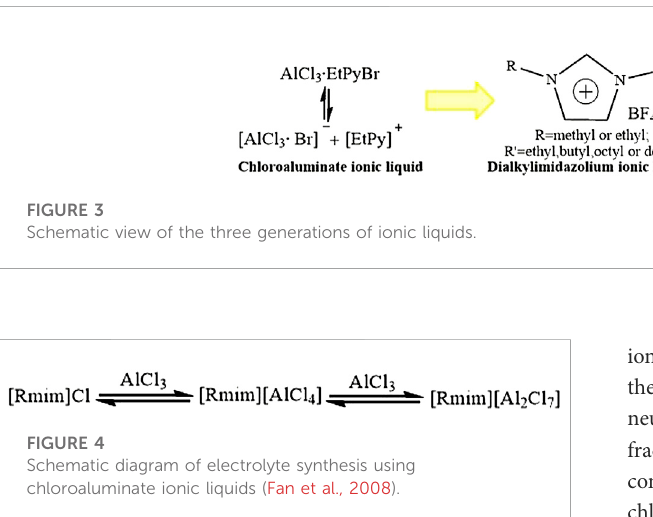
FIGURE 4 Schematic diagram of electrolyte synthesis using chloroaluminate ionic liquids (Fan et al.,